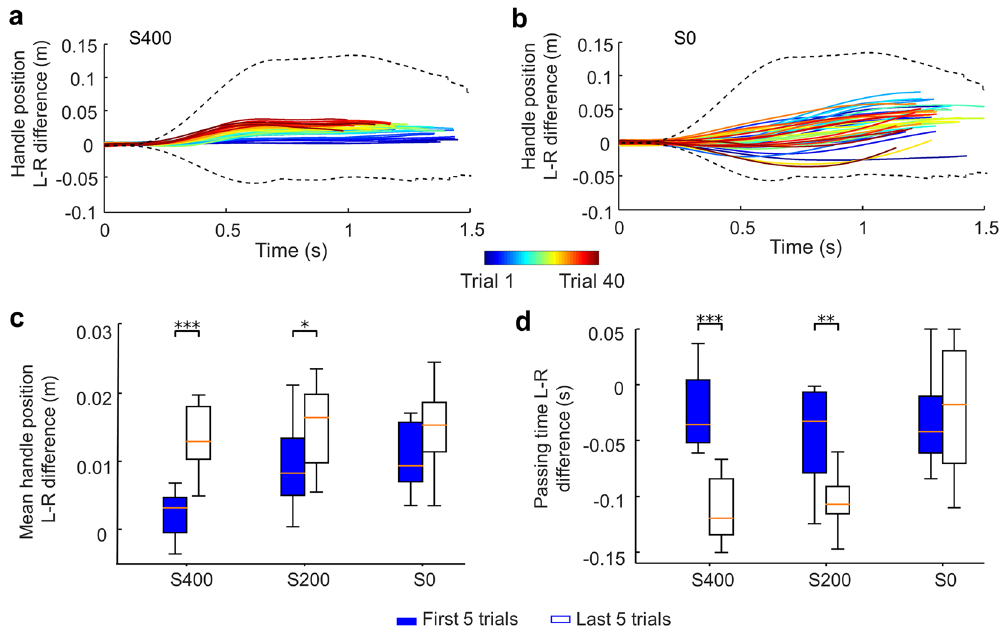
Figure 3. Changes of spatiotemporal coordination across successful trials . ( a ) Hand position difference from individual successful trials performed by a representative dyad in the S400 condition. Early trials are plotted as blue traces and subsequent trials are denoted by ’warmer’ colors. Dashed lines represent boundaries of feasible strategies obtained from simulations. ( b ) Hand position difference from another representative dyad in the S0 condition are plotted in the same format as ( a ). Data shown in ( a ) and ( b ) are from 40 successful trials. ( c ) Comparison of mean hand position difference between the first and last five successful trials. ( d ) Comparison of time at which left and right handles passed the 0.02-m distance from the starting point from the first and last five successful trials (*, ** and *** denote p < 0.05, 0.01 and 0.001, respectively). Data shown in panels ( c ) and ( d ) are from 48 subjects (24 dyads; 8 dyads per experimental condition). Vertical bars denote 1.5 interquartile range. Rainbow-like color distributions can be seen in ( a ) but not in ( b ), indicating the emergence of consistent co-adaptation only in the S400 condition and not in